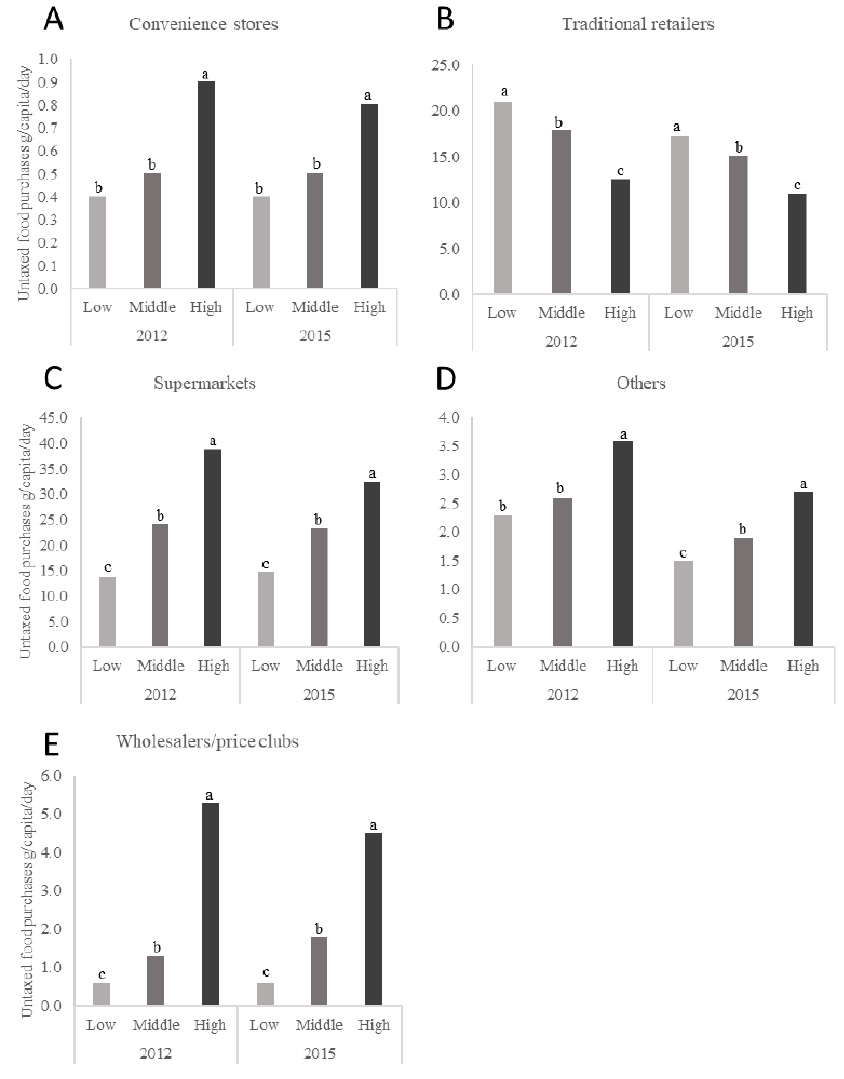
Figure 4. Daily per capita purchases of untaxed foods in urban Mexican households, according to SES, for the years 2012 and 2015. n = 959 in the low-SES, n = 3133 in the medium-SES, and n = 1721 in the high-SES group in 2012 and n = 1170 in the low-SEs, n = 2690 in the medium-SES, and n = 1633 in the high-SES group in 2015. Subgraphs refer to untaxed food purchases by store-type including ( A ) convenience stores, ( B ) traditional retailers, ( C ) supermarkets, ( D ) home water-delivery, and ( E ) wholesalers and price clubs. Values represent weighted unadjusted means. SES classification is based on the socioeconomic index provided by Nielsen. Multivariate linear regression models were used to predict per capita daily purchases of untaxed foods according to store-type, SES, and year of purchases. Data presented are restricted to the Nielsen CPS purchasing information for 2012 and 2015 only for clarity. However, p -values represent the p -trend for years 2012, 2013, 2014, and 2015. Labeled means with a different letter represent significant differences between the SES categories means ( p -trend < 0.05) where the letters a,b,c are used to differentiate the highest, middle, and lowest mean values for each figure in the panel. Source: Authors’ own analyses and calculations based on data from Nielsen through its Mexico Consumer Panel Service (CPS) for the food and beverage categories for January 2012 to December 2015. The Nielsen Company, 2016. Nielsen is not responsible for and had no role in preparing the results reported in this